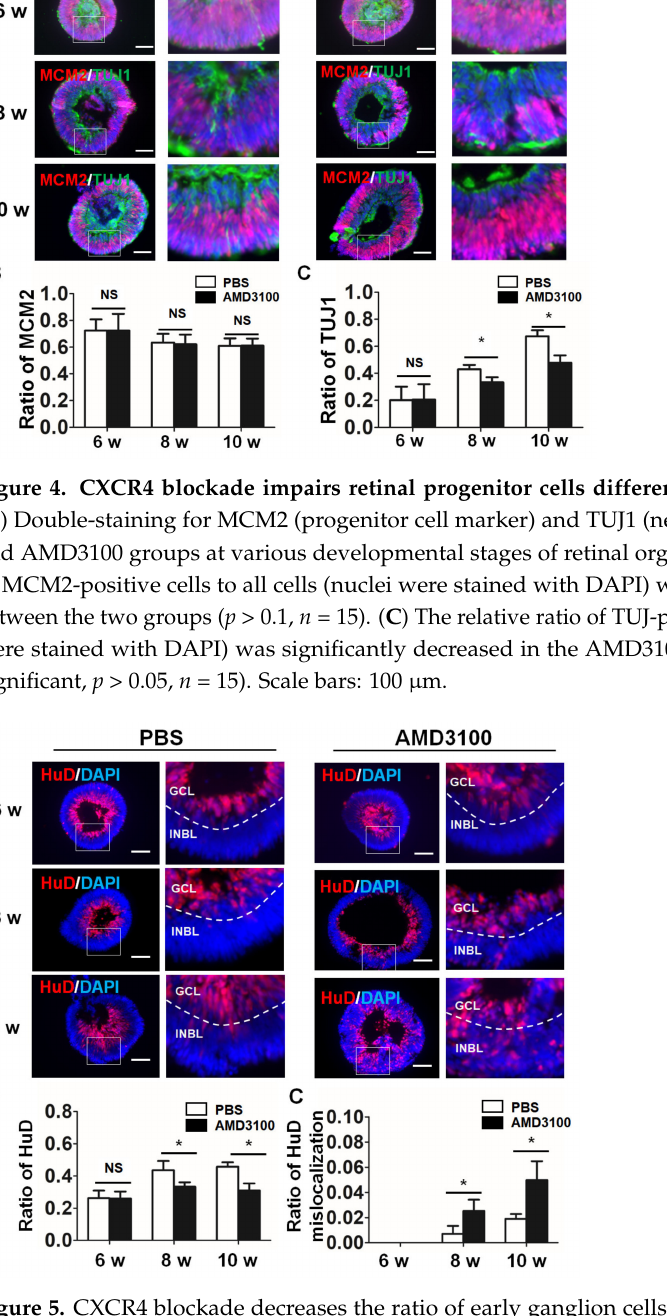
Figure 5. CXCR4 blockade decreases the ratio of early ganglion cells and results in their mislocal- ization in retinal organoids. ( A ) Ganglion cells were stained by HUD from 6 weeks to 10 weeks to detect abnormal location of HUD-staining in the AMD3100 treatment group (white arrowhead). ( B ) The relative ratio of HUD-positive cells to all cells (nuclei were stained with DAPI) significantly decreased in the AMD3100 group (* p < 0.05, NS: Not Significant, p > 0.1, n = 15). ( C ) The relative ratio of HUD-positive cells to all cells (nuclei were stained with DAPI) located in the INBL significantly increased in the AMD3100 group (* p < 0.05, n = 15). Scale bars: 100 µ